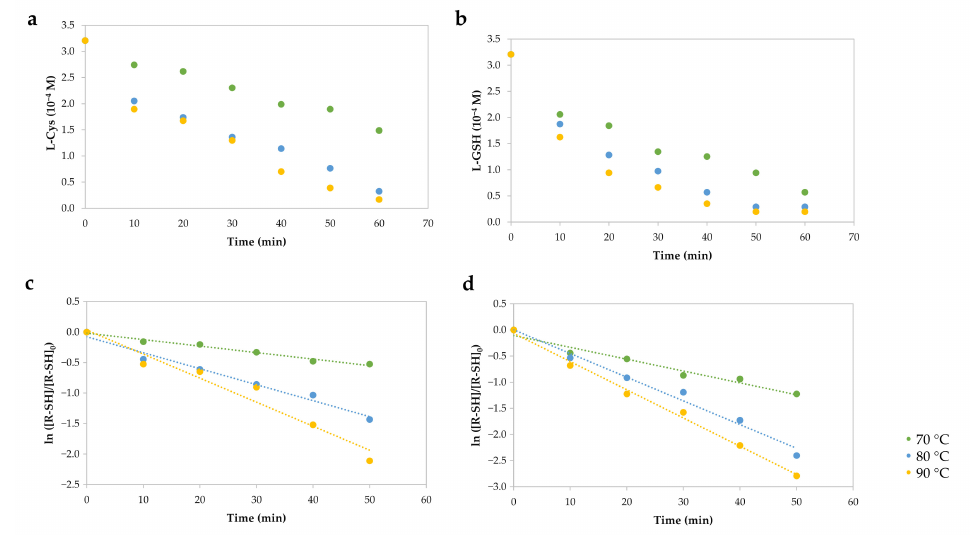
Figure 2. Reaction kinetics parameters of ( a ) L-Cys and ( b ) L-GSH with ACR at pH 7.3 and different temperatures. Pseudo-first-order rate constants ( k obs ) for ( c ) L-Cys and ( d ) L-GSH were determined from plots of ln ([ R − SH ] / [ R − SH ] 0 ) vs. time.